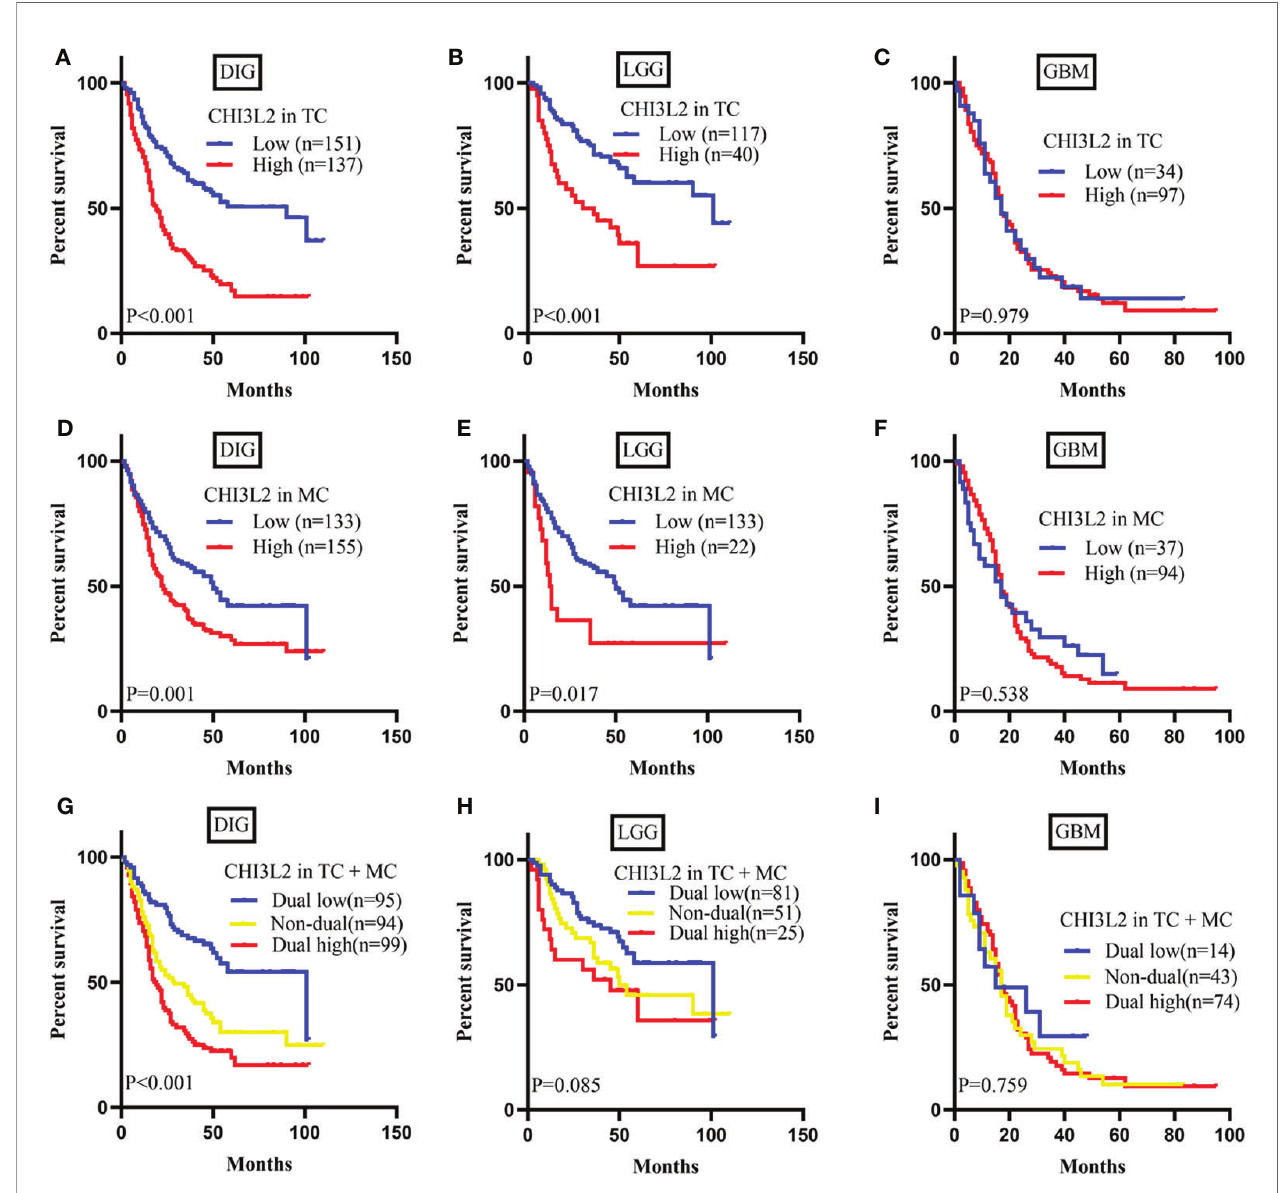
FIGURE 3 | CHI3L2 protein expression affects overall survival (OS) in glioma patients. Kaplan-Meier curves showing a correction of CHI3L2 expression with OS in tumor cells (A – C) , macrophage cells (D – F) , and tumor cells + macrophages cells (G – I) of diffusely in fi ltrating glioma (DIG), LGG, and